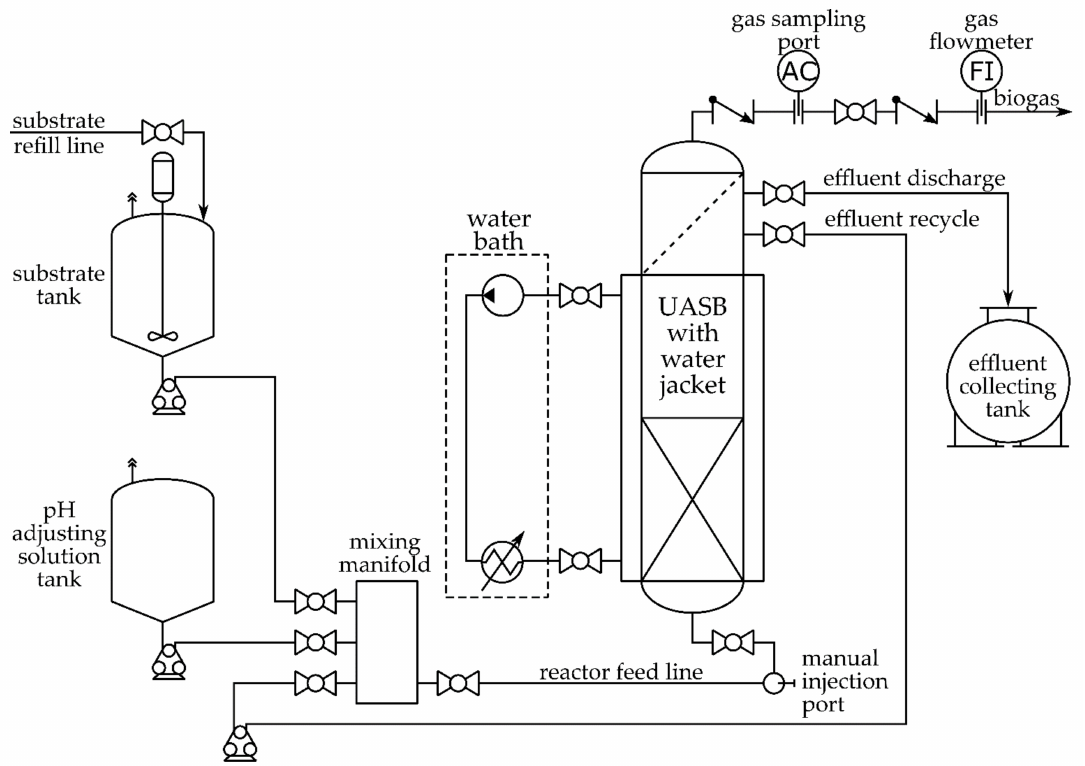
Figure 2. Recommended flowchart of UASB infrastructure